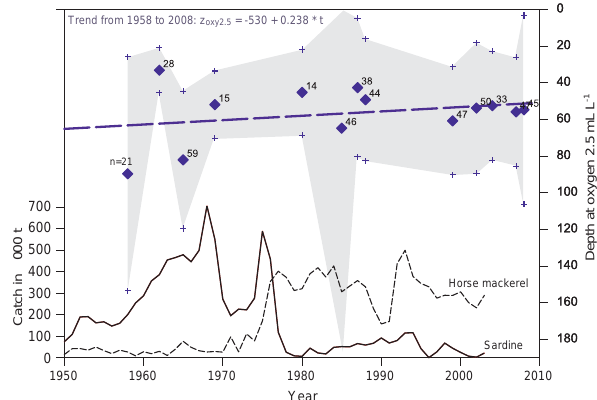
Fig. 9. Upper part: Development of the O 2 =2.5mLL − 1 iso-surface in summer (January to March) from 1958 to 2008 off northern Namibia. Mean depth ( ♦ ) ± s (standard deviation, +, shaded area) of oxygen concentration =2.5mLO 2 L − 1 was calculated for the area between 15 ◦ S and 24 ◦ S, and between the coast and 1000m water depth. n is the number of stations used for calculating the mean in the respective year. The horizontal line indicates the trend in the overall mean depth of oxygen =2.5mLO 2 L − 1 ( z oxy2 . 5 ). The general trend can be described as a shoaling of the 2.5mLO 2 L − 1 iso-surface over the last 50 years (Data from National Oceano- graphic Data Center 2008; courtesy of Kreiner, NatMIRC and Ekau, 2007, 2008). Lower part: Development of sardine (solid line) and horse mackerel (dashed line) catches in metric tons during the last 50 years in the Namibian EEZ (Source: